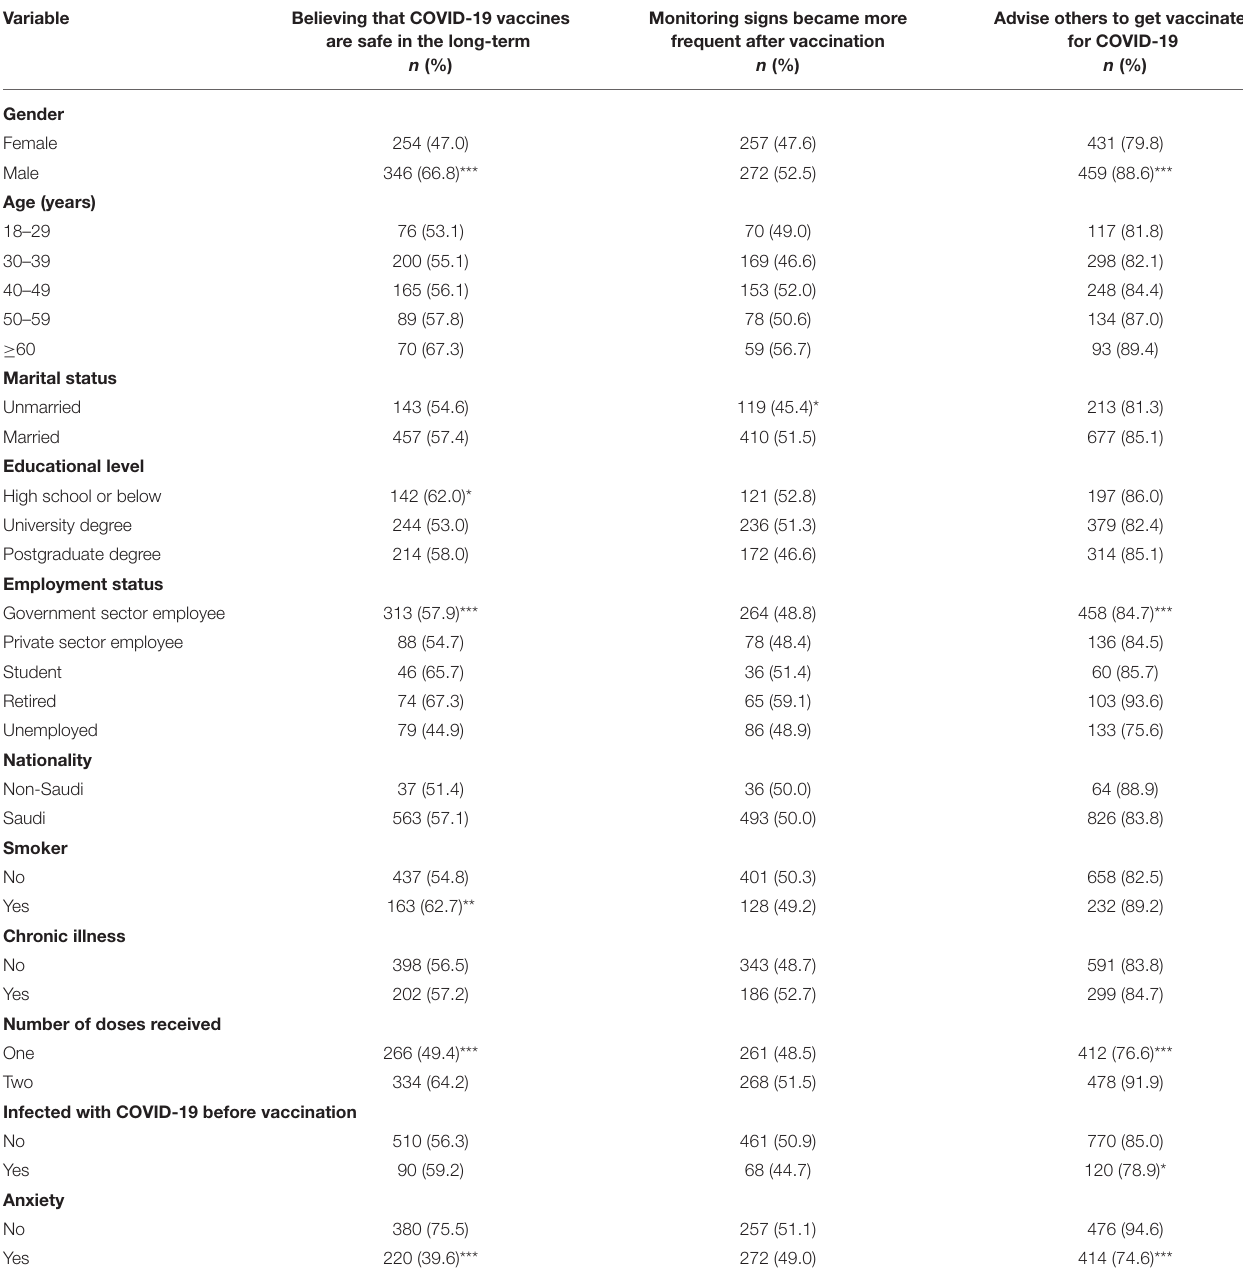
TABLE 6 | Participants’ perceptions about COVID-19 vaccines after vaccination by demographic and health characteristics. Variable Believing that COVID-19 vaccines